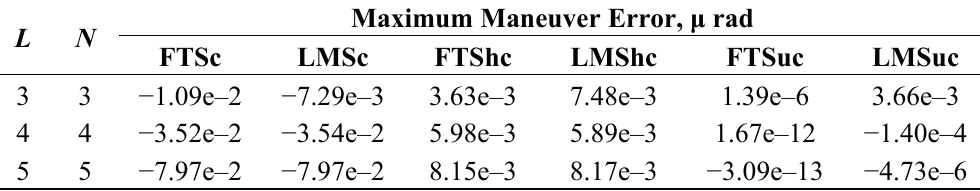
New Table 17. Maximum maneuver error over 2 s